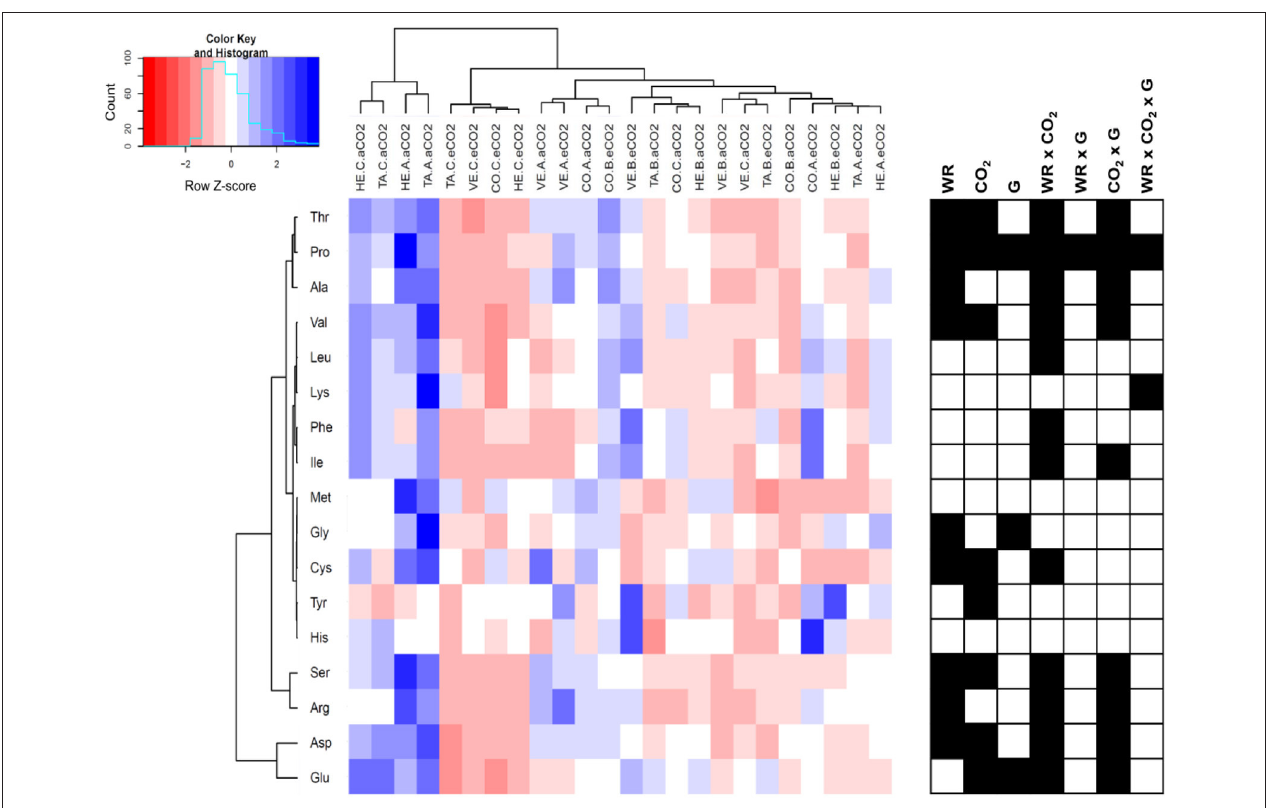
FIGURE 5 | Hierarchically clustered heat map of amino acid content of four sweet pepper genotypes (TA, Tallante; CO, Coyote; HE, Herminio; VE, Velez) grown hydroponically under different [CO 2 ] (aCO 2 , ambient [CO 2 ]; eCO 2 , elevated [CO 2 ]) and water regimes (A, control; B, mild water stress; C, moderate water stress). Values were scaled in the row direction as presented in the color key. Significance of main factors (WR, water regime; CO 2 , [CO 2 ]; and G, genotype) and their interactions are shown as black cells ( P <